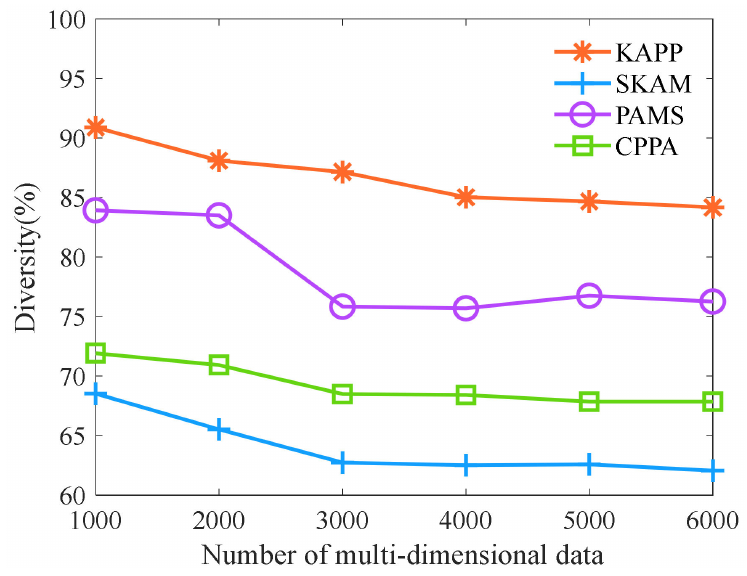
Figure 6. Comparison of